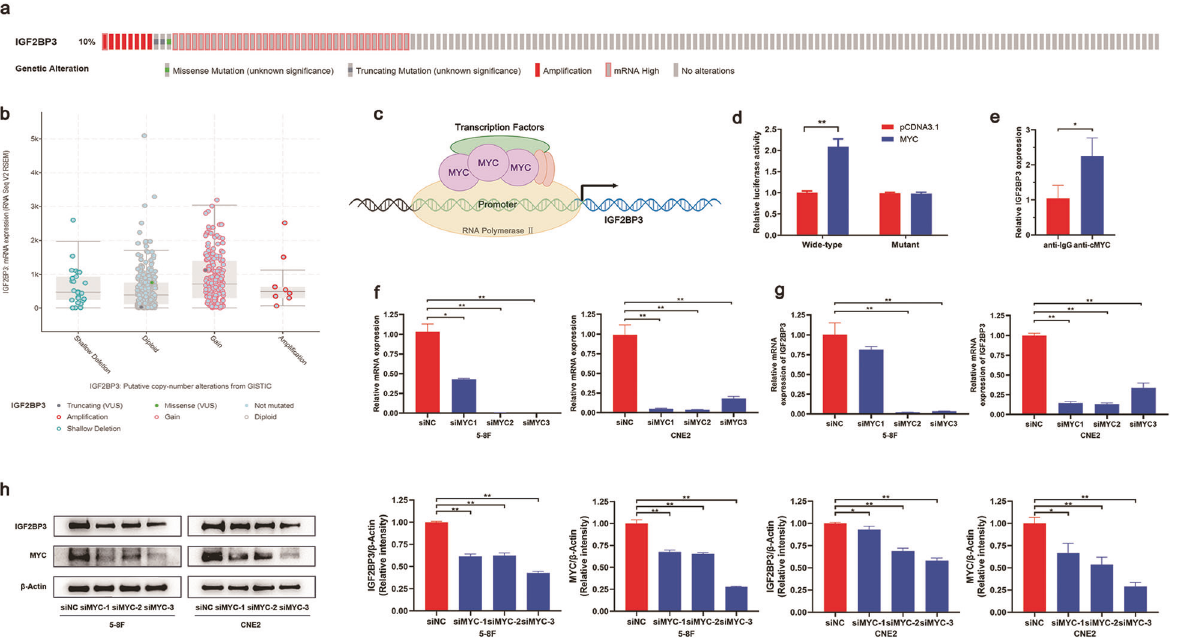
Fig. 3 The expression of IGF2BP3 is regulated by MYC, which acts as a transcription factor. a , b The genetic alterations of IGF2BP3 in TCGA data predicted by cBioPortal. c Diagram of transcription factors MYC binds to the promoter region of IGF2BP3. d Luciferase reporter assay veri fi ed the direct target binding of MYC and IGF2BP3. e CHIP assay was performed to measure the connection between MYC and IGF2BP3 in NPC cells. The enrichment of ChIP is normalized by input DNA via qRT-PCR. f – h qRT-PCR and western blot results of MYC and IGF2BP3 mRNA and protein expression in 5 – 8 F and CNE2 cells after MYC knockdown. Data was shown as the mean ± standard deviation of three independent experiments. * P < 0.05, ** P <